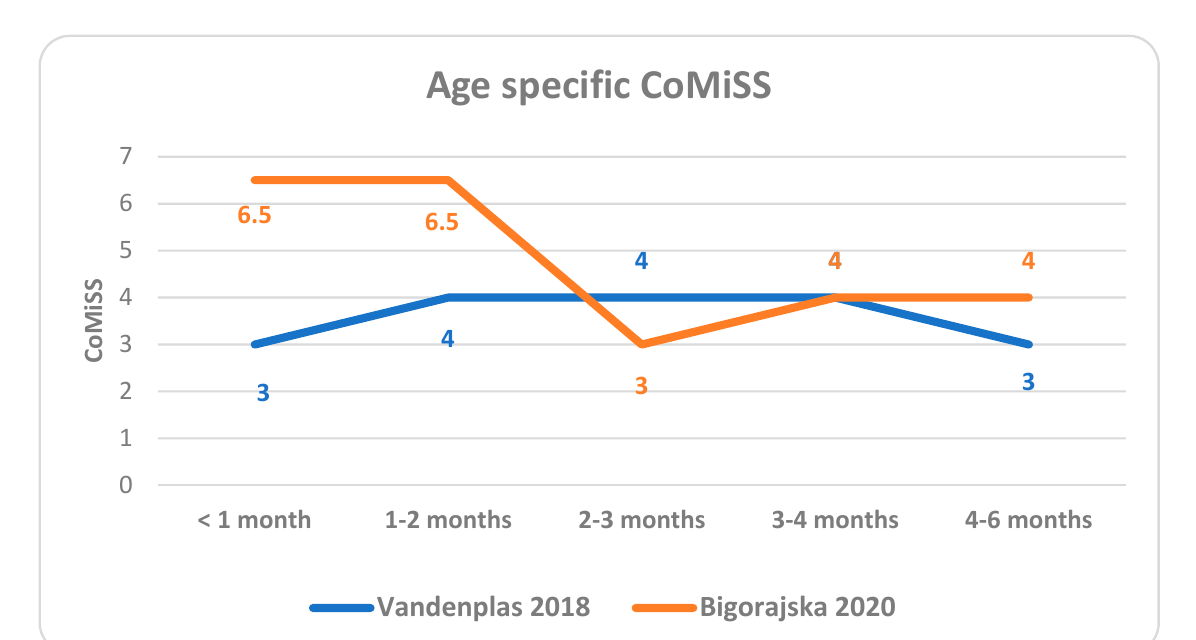
Figure 1. Age specific median CoMiSS.